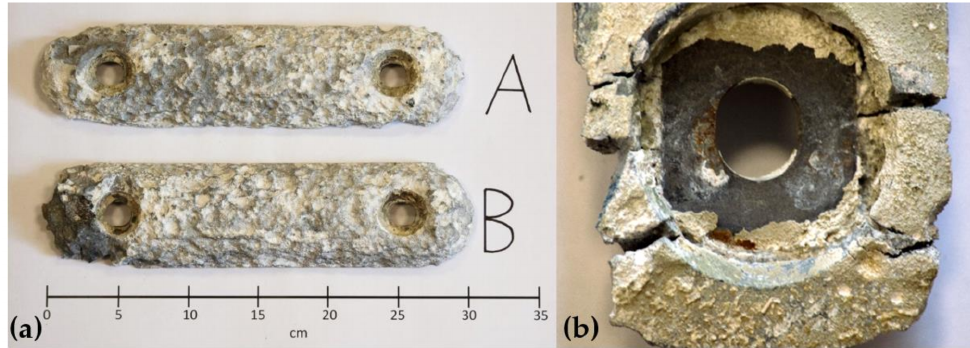
Figure 5. ( a ) Two end-of-life anodes (A) and (B) and ( b ) cracks of anode B in